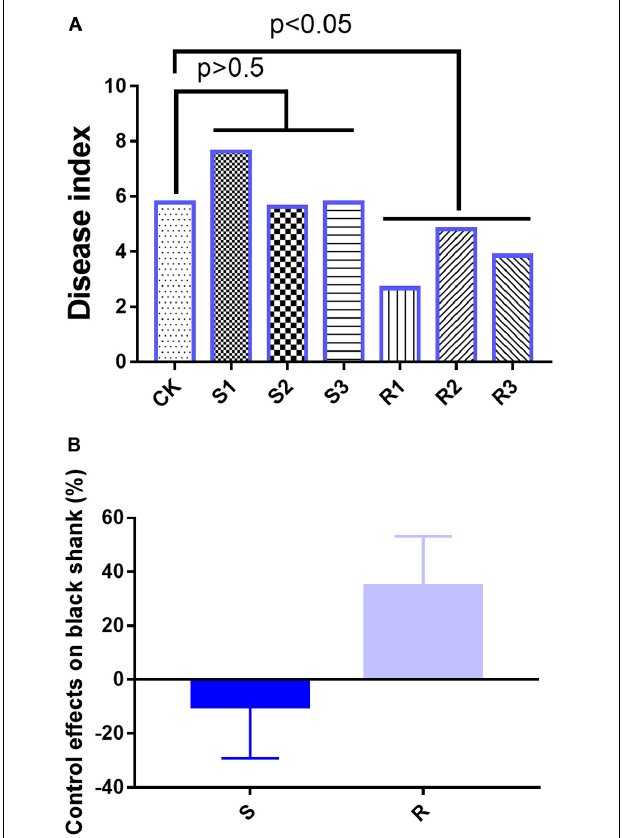
FIGURE 1 | (A) Disease index and (B) suppression of black shank. CK, control group; R, roots with three replicate samples; S, soil with three replicate samples. The soil samples taken together were not significantly different from the control, where the root samples were different at p =